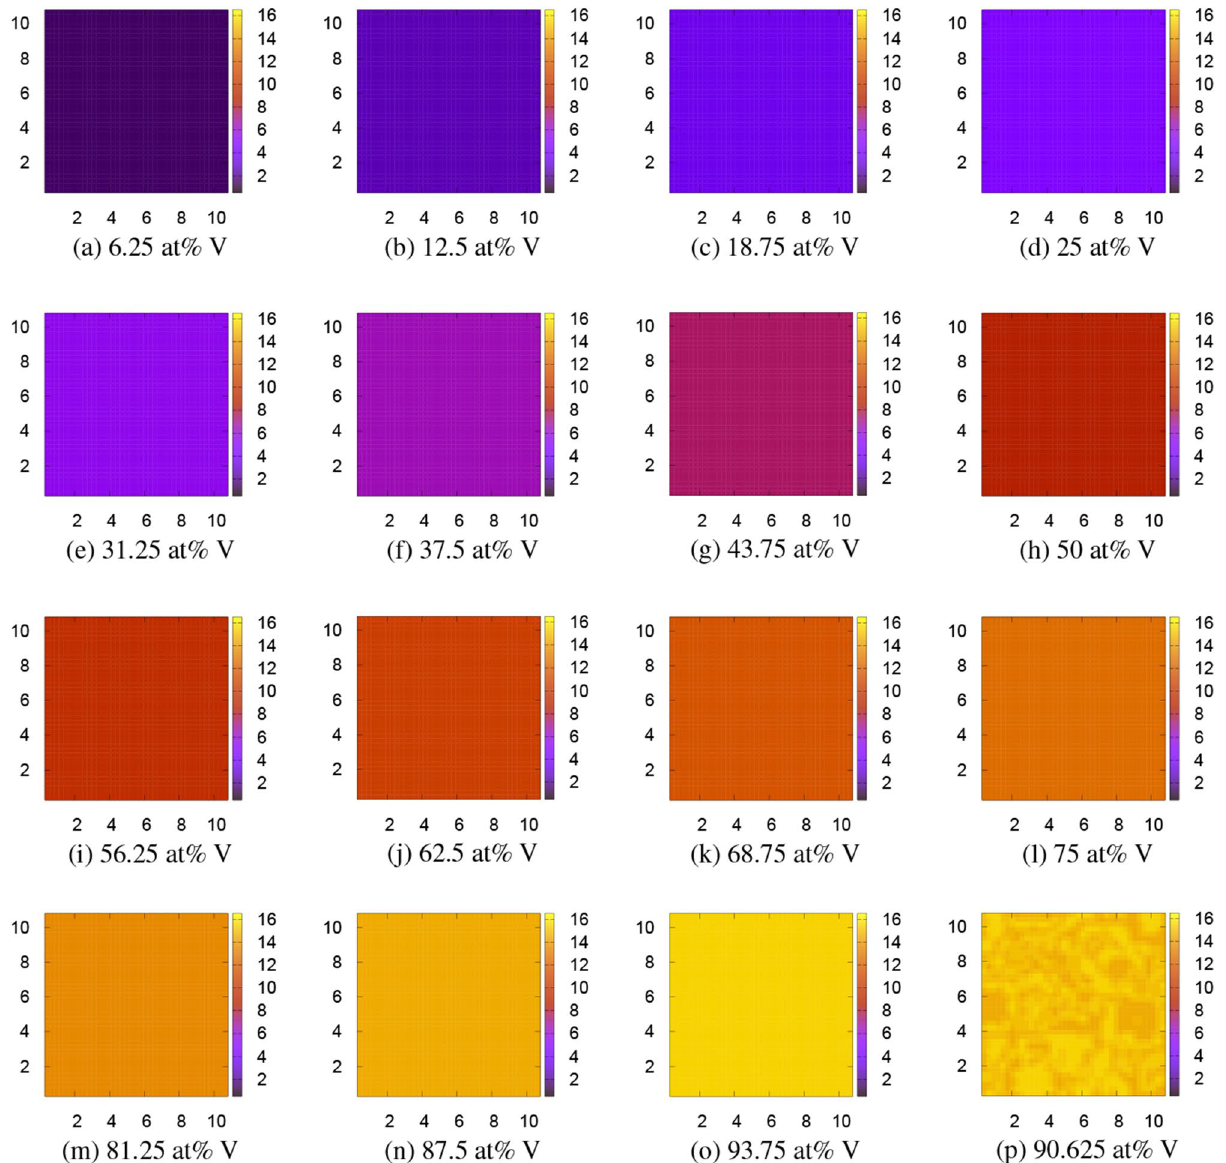
Figure 6. Microstructures of the Ti 16 the quadruple 16-atom unit cell at 0 K. The color bar indicates the V concentration φ V (